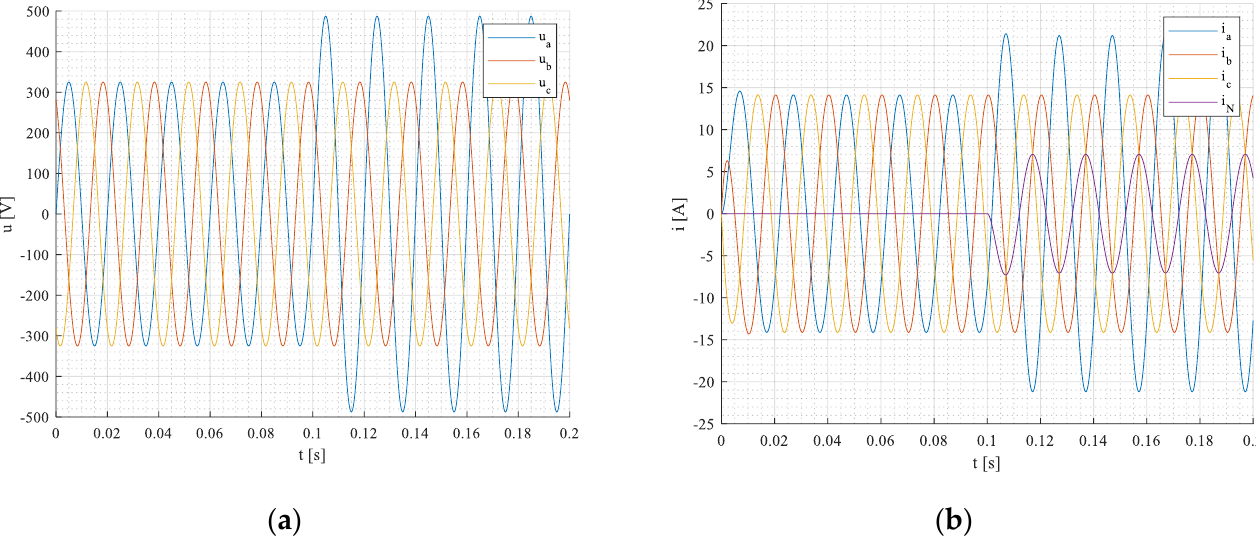
Network voltages and currents in a , b , c - coordinate system at steady states are shown in Figure 28a,b.